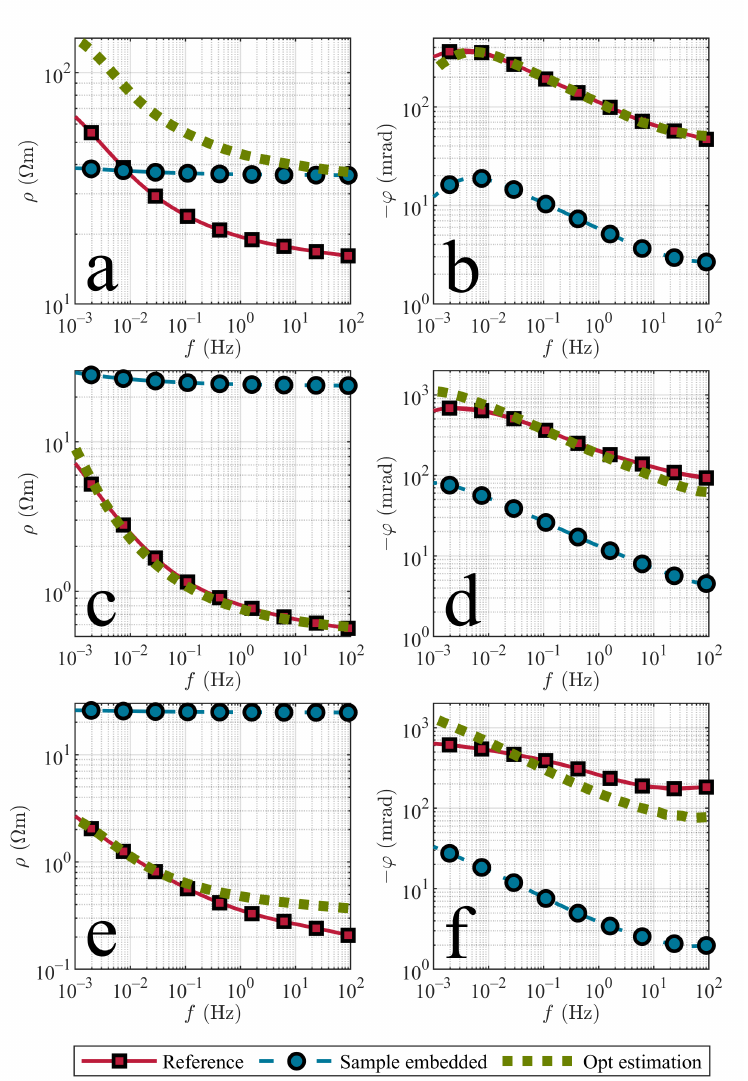
Figure 5. Resistivity magnitude spectra ( left column ) and phase spectra ( right column ) of three selected samples of the entire dataset. Top row ( a , b ): the Zn–Ba-rich sulfide no. 14 (numbers following [13]). Middle row ( c , d ): The Cu–Zn rich sample no. 20. Bottom row ( e , f ): The Cu-rich sample no. 25. The red squares (reference) indicate the direct measurements on the cylindrical sample and the blue circles indicate the measurements on the embedded samples; the dotted line is a the phase shift of the embedded measurement shifted by a constant factor to match the